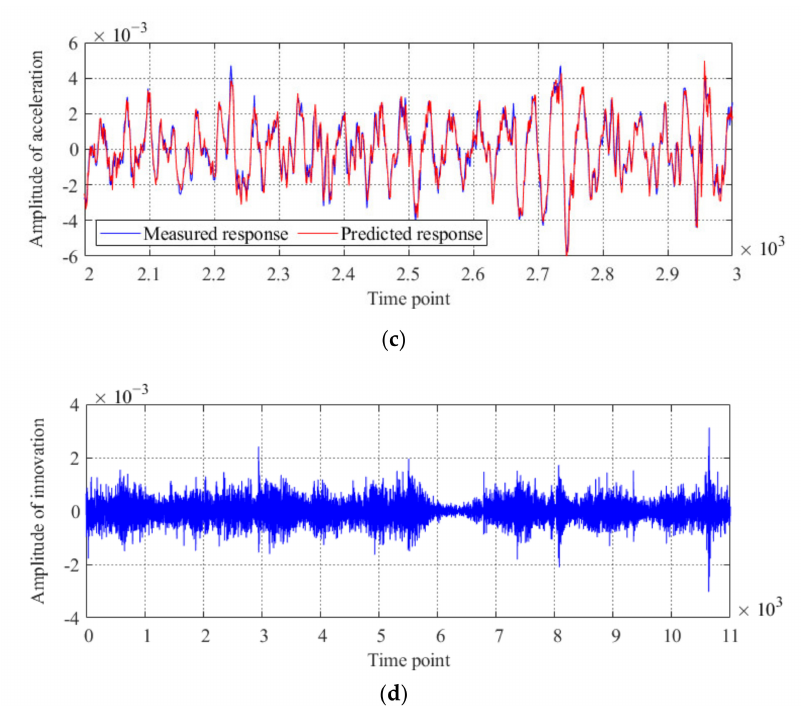
Figure 13. Results of the Kalman filter obtained by using the acceleration response of the actual bridge obtained under the first case: ( a ) measured acceleration response of sensor #2; ( b ) comparison of the measured and predicted acceleration responses of sensor #2; ( c ) detailed parts of the innovation from time points 2000 to 3000, and ( d ) innovation obtained by using the acceleration response of sensor #2.